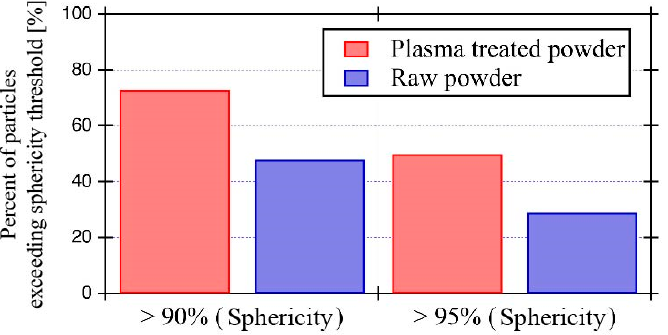
Figure 5. Percentage of particles with sphericity exceeding 90% and 95% thresholds in each powder.